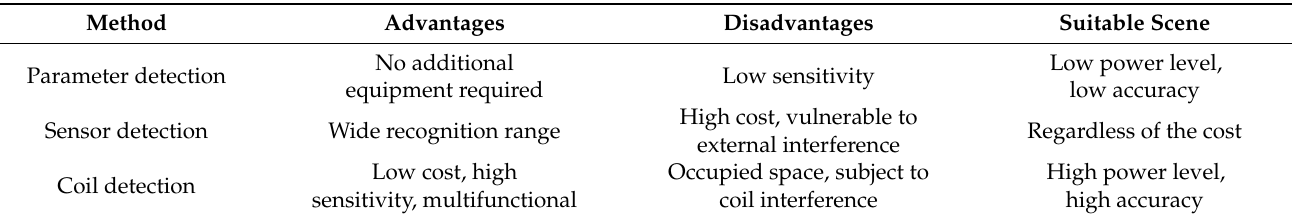
Table 1. Comparison of FOD